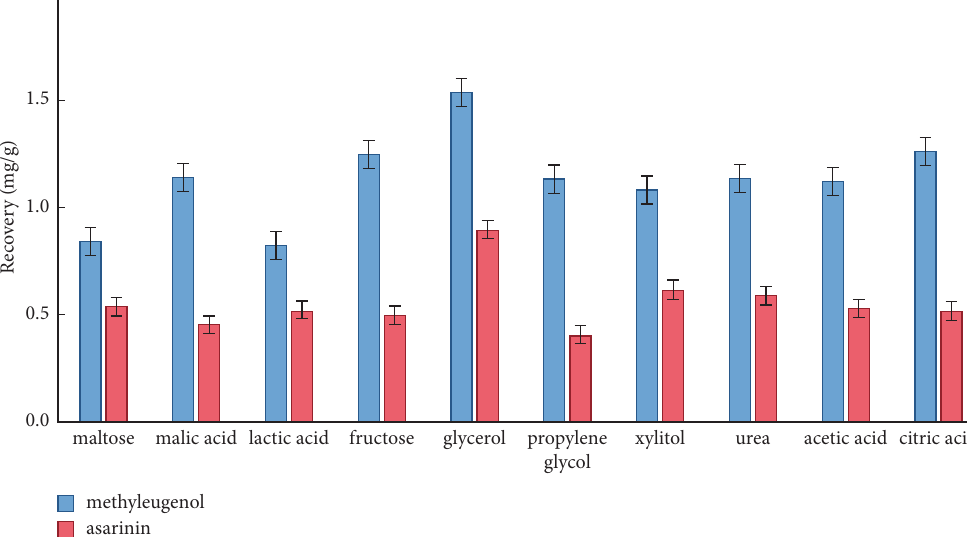
Figure 3: Effect of DES types, extraction conditions: sample amount, 50mg; DES volume, 1.5mL; ultrasonic temperature, 60 ° C; ultrasonic time, 30min; and vortex oscillation, 5min.